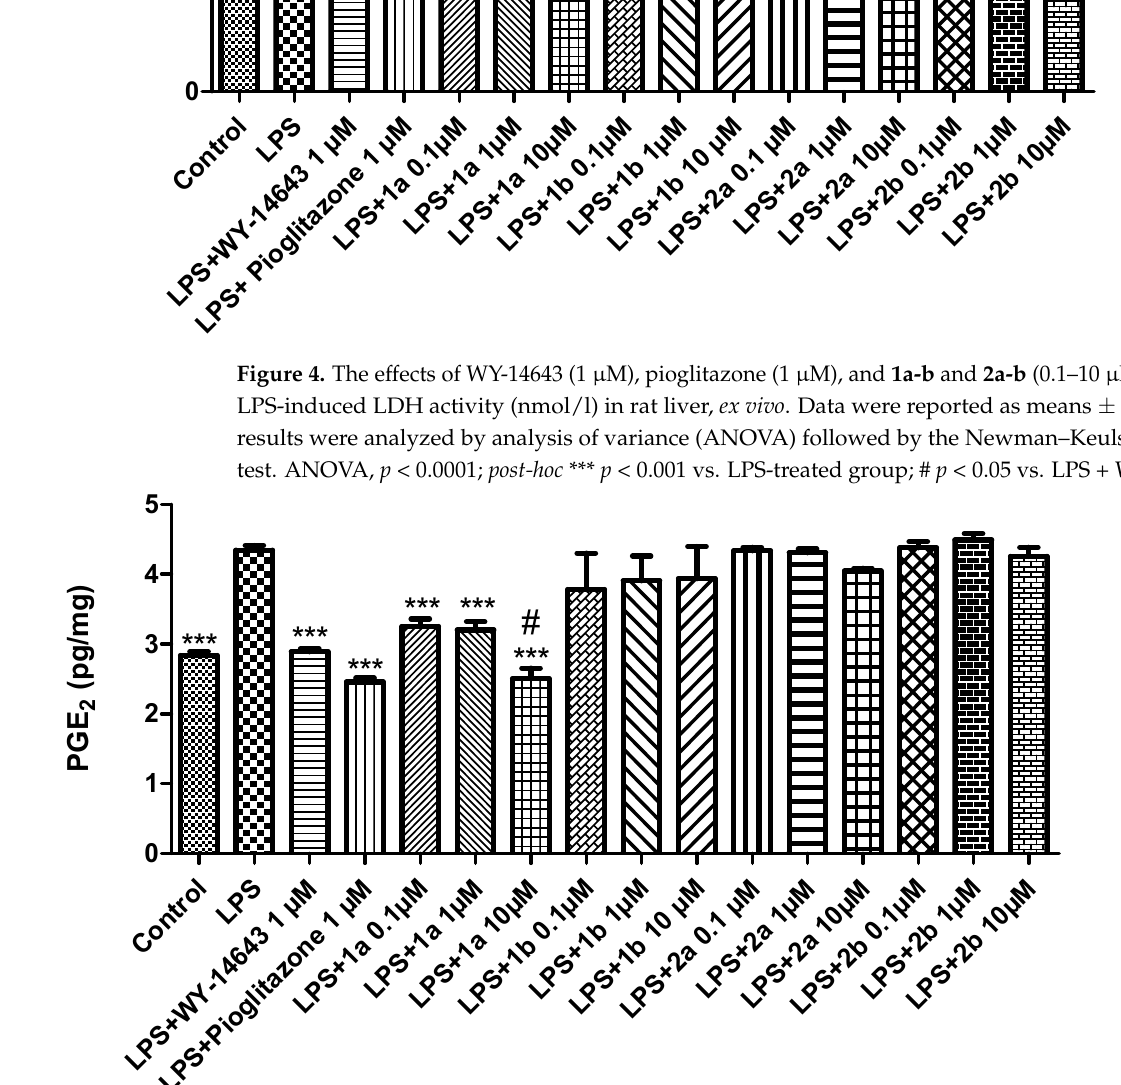
Figure 5. The effects of WY-14643 (1 µ M), pioglitazone (1 µ M), and 1a-b and 2a-b (0.1–10 µ M), on the LPS-induced production of PGE 2 (pg/mg) in rat liver, ex vivo. Data were reported as means ± SEM. The results were analyzed by analysis of variance (ANOVA) followed by the Newman–Keuls post-hoc test. ANOVA, p < 0.0001; post-hoc *** p < 0.001 vs. LPS-treated group; # p < 0.05 vs. LPS + WY ‐ 14643.